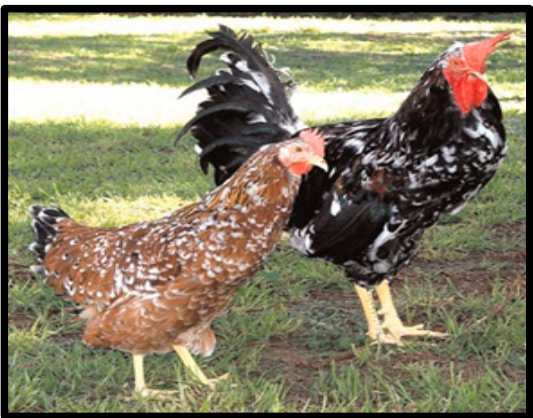
Figure 2. Venda chicken breeds. Source: [42].